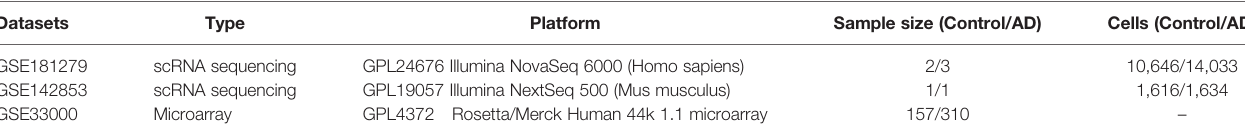
TABLE 1 | The enrolled datasets in the current